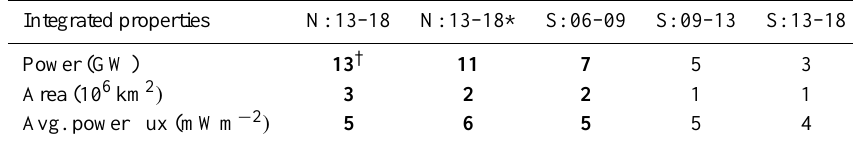
Table 4. Integral properties for four regions of enhanced Poynting flux for 14:00–15:00 UT, 23 November 1999. Integrated power density extends down to a contour of 2.5mWm − 2 in Figure 5c, except as